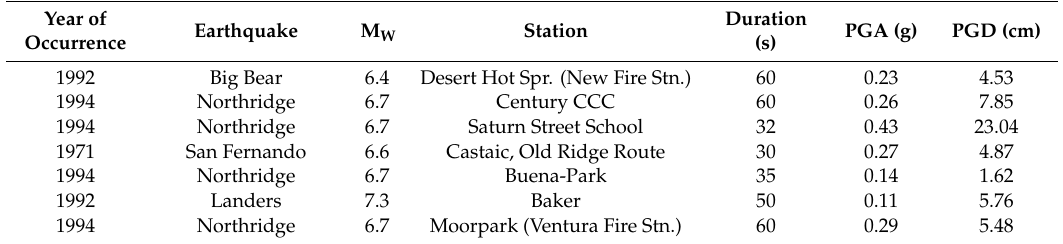
Table 2. Earthquake records considered in the